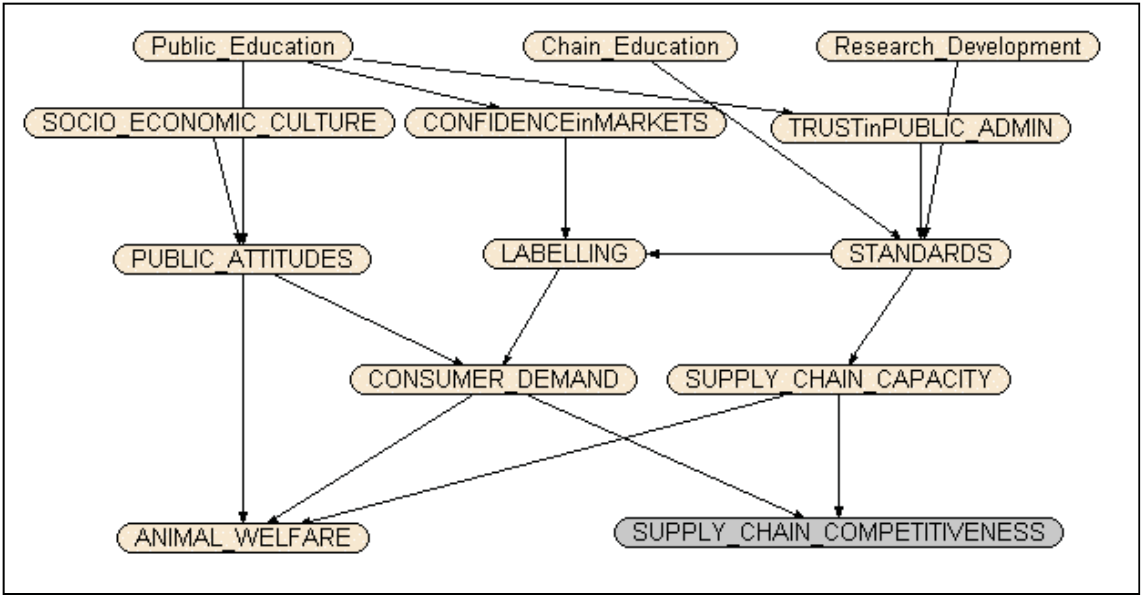
Figure 3. EconWelfare Belief Network (beta